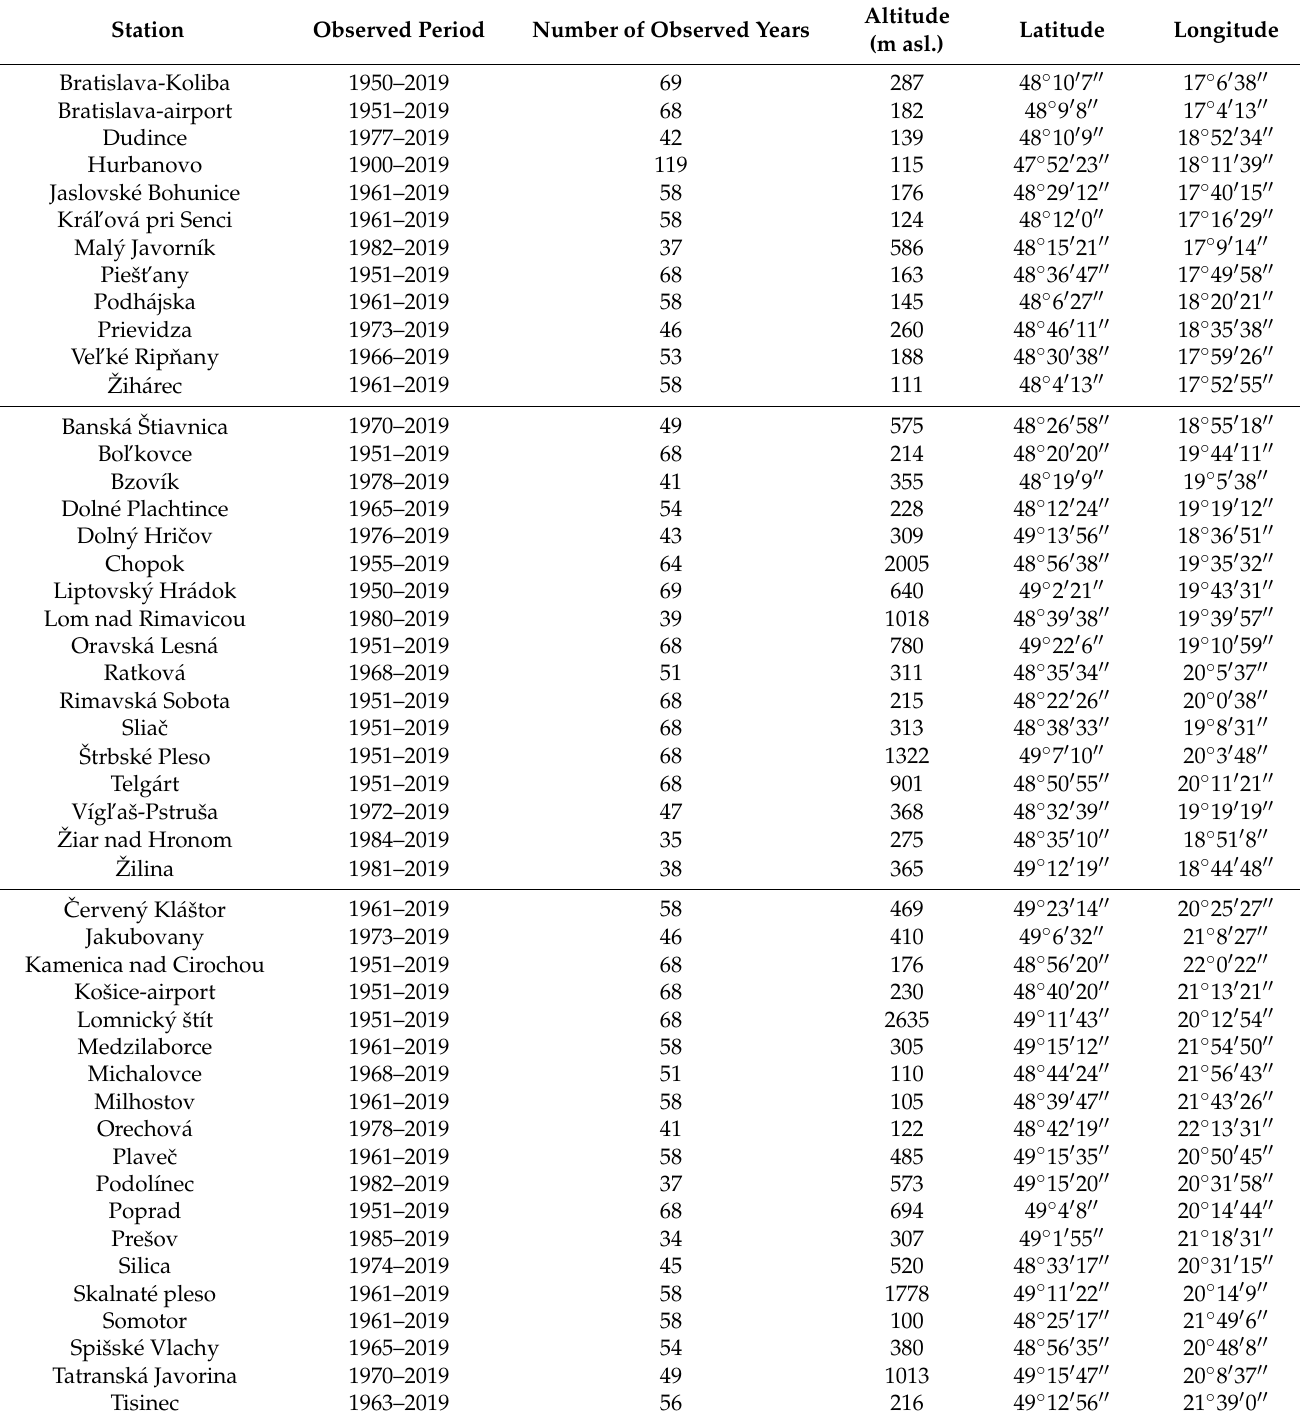
Table 1. List of observed stations with their altitude and